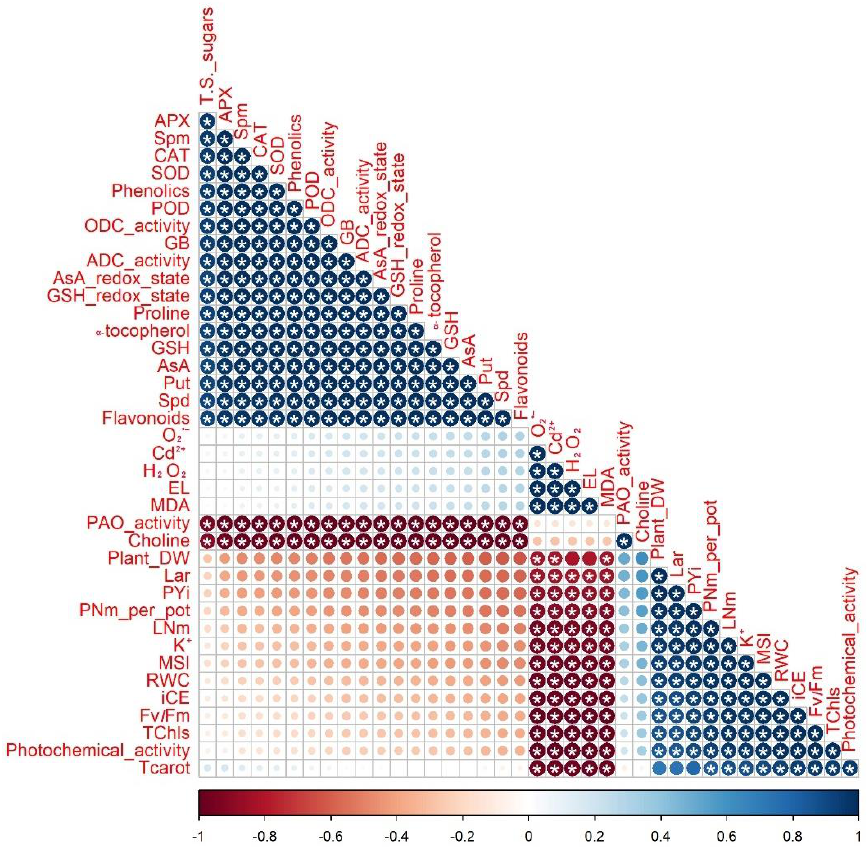
Figure 9. Graph of Pearson’s correlation analysis among the parameters examined. The colors represent variations in the resulting data. * indicates significance at p ≤ 0.05. TChls = Total chlorophyll, TCarot = Total Carotenoids, iCE = instantaneous carboxylation efficiency, Fv/Fm = chlorophyll “a” fluorescence, LNm = leaf number, LAr = leaf area, DW = dry weight, PNm = pod number, PYi = pod yield, AsA = Ascorbate, GSH= Glutathione, O 2 •− = Superoxide, H 2 O 2 = Hydrogen peroxide, MDA = Malondialdehyde, EL = Electrolyte leakage, RWC = Relative water content, SOD = Superoxide dismutase, CAT= Catalase, APX = Ascorbate peroxidase, POD = Peroxidase, Put = putrescine, Spd = Spermidine, Spm = Spermine, ADC = Arginine decarboxylase, ODC = Ornithine decarboxylase, and PAO = Polyamine oxidase.